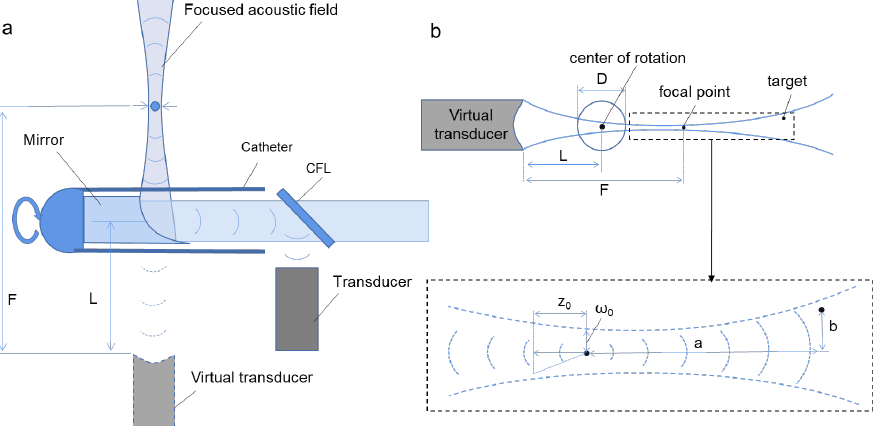
Figure 1. The schematics of the acoustically focused photoacoustic/ultrasound endoscopic imaging algorithm. ( a ) The diagram of the probe. Using a parabolic mirror, which acts as an acoustic lens, creates a focused acoustic field at the side of the probe; ( b ) The schematic of the approximate Gaussian acoustic field. The parabolic mirror rotates, i.e., the virtual transducer rotates with radius L. CFL: Calcium Fluoride Lenses. D is the diameter of the photoacoustic endoscopic probe.